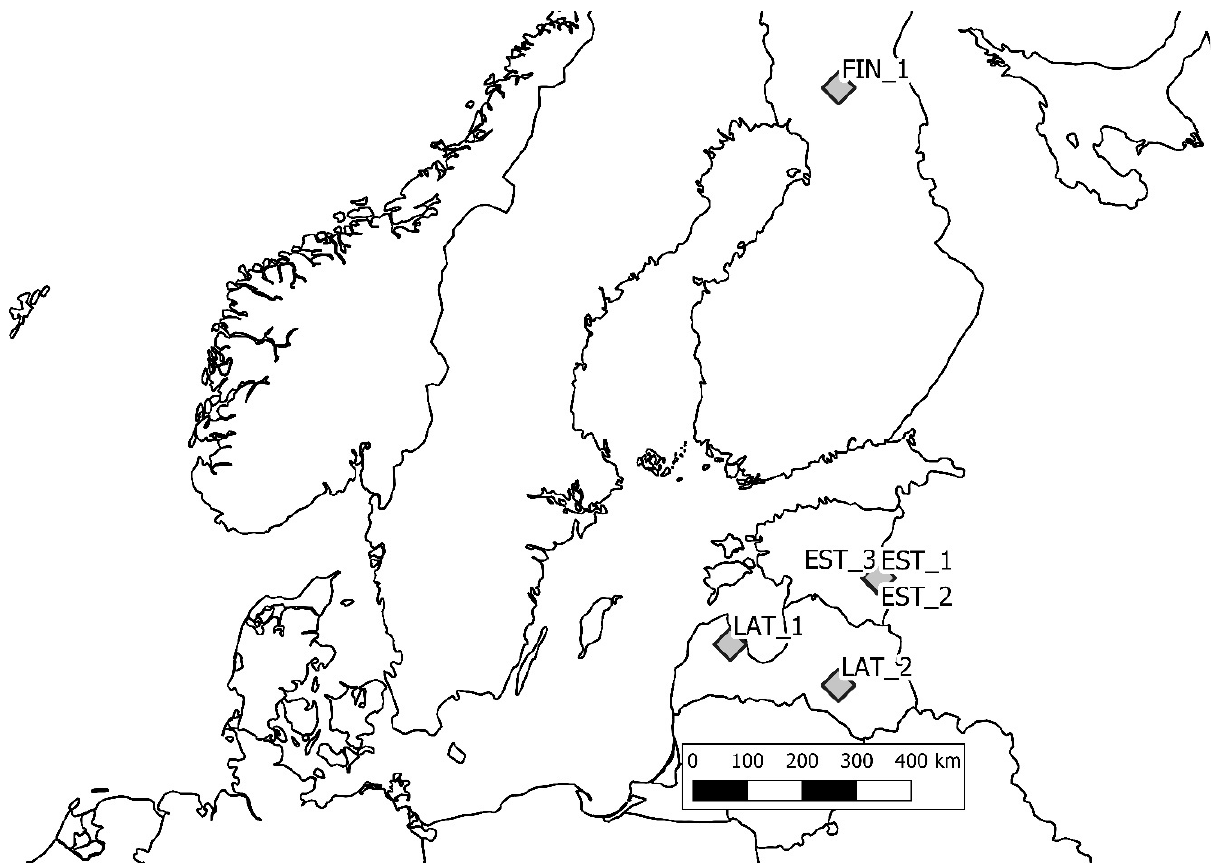
Figure 1. Location of the studied stands of Scots pine represented by the time series of height increment in the Baltic Sea region.